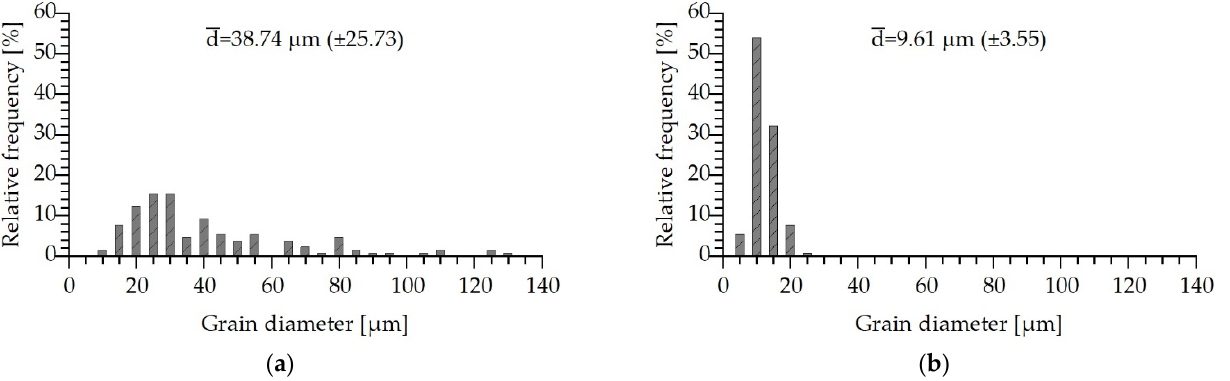
Figure 4. Grain size distribution of the twin-roll cast magnesium wire pre-profile AZ31, ( a ) peripheral zone and ( b ) wire centre.